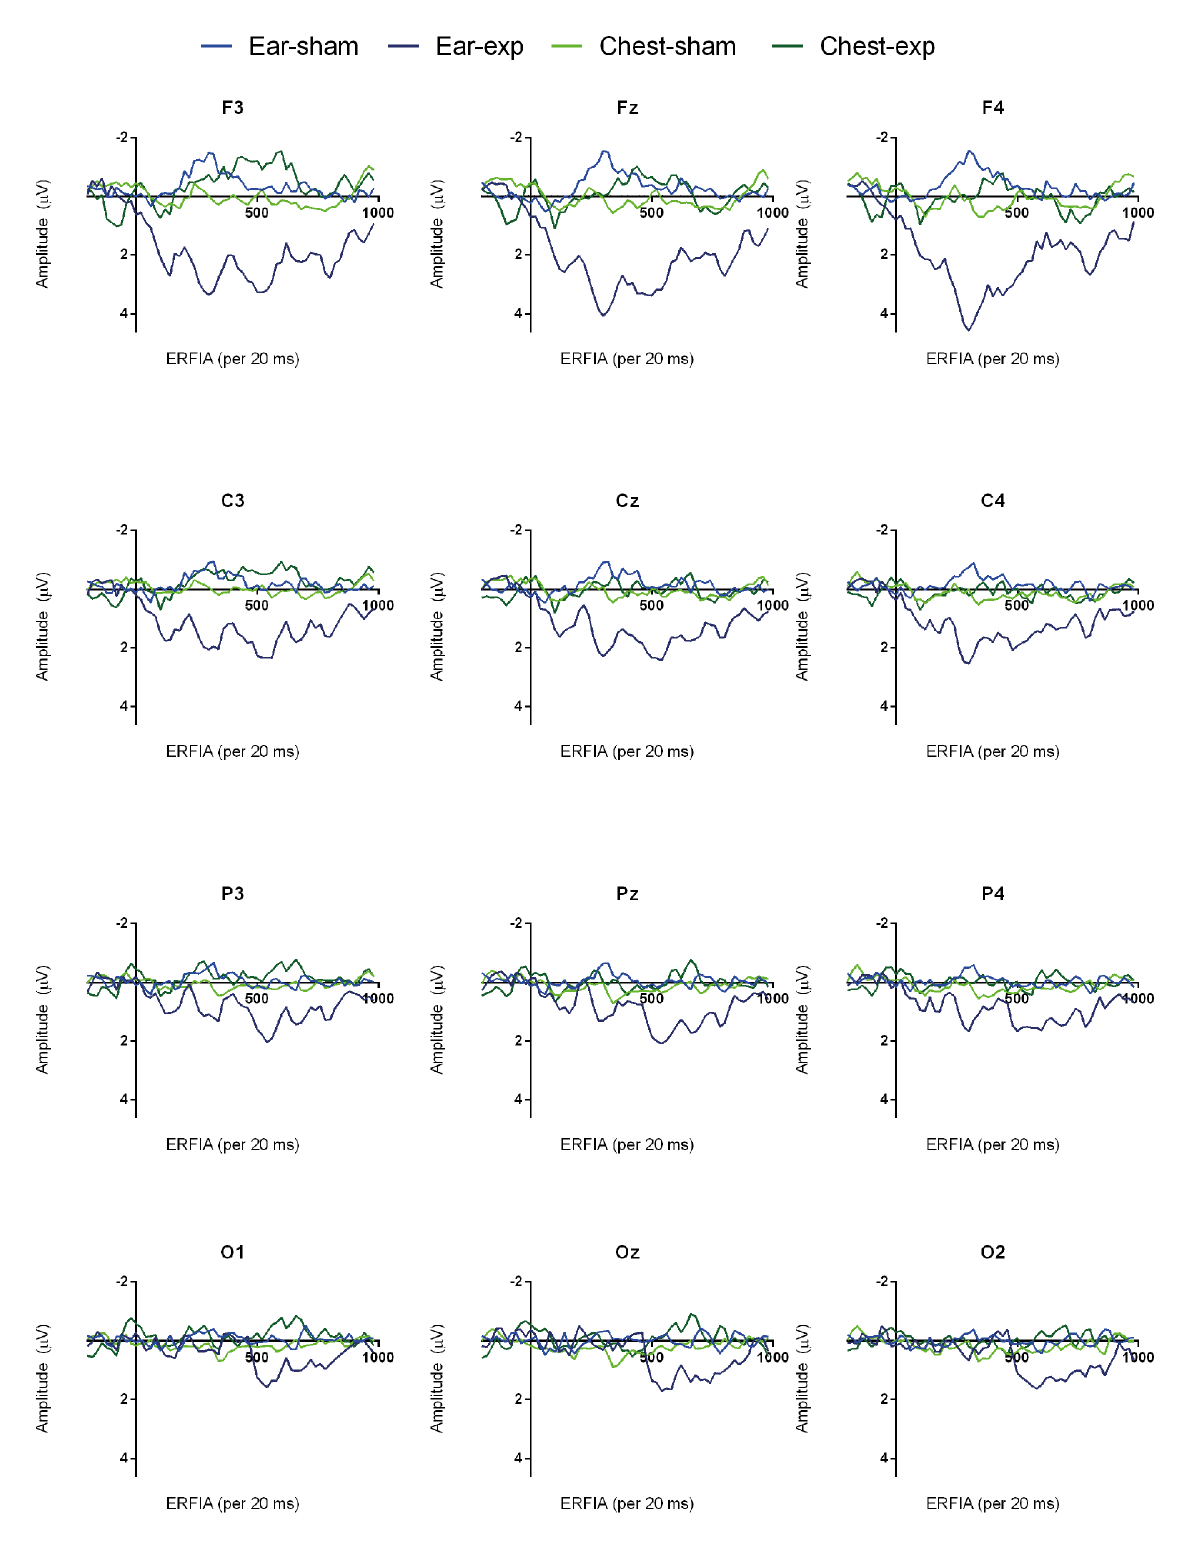
Fig 2. Event Related Fixed Interval Area (per 20ms) grand averages in twelve EEG locations. doi:10.1371/journal.pone.0125390.g002 PLOS ONE | DOI:10.1371/journal.pone.0125390 May 11,